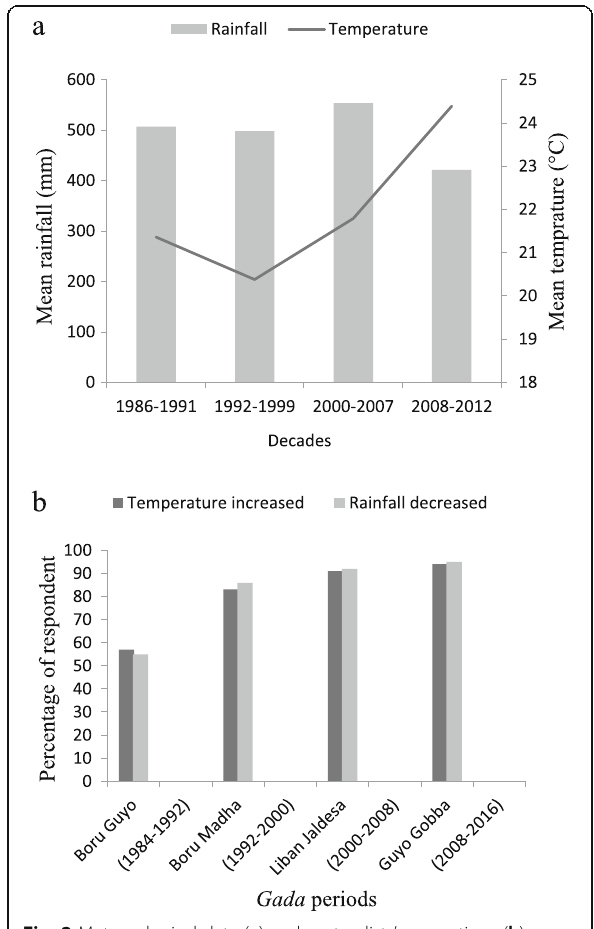
Fig. 2 Meteorological data ( a ) and pastoralists ’ perceptions ( b ) on temperature and rainfall trends over the last four decades in Borana, southern Ethiopia